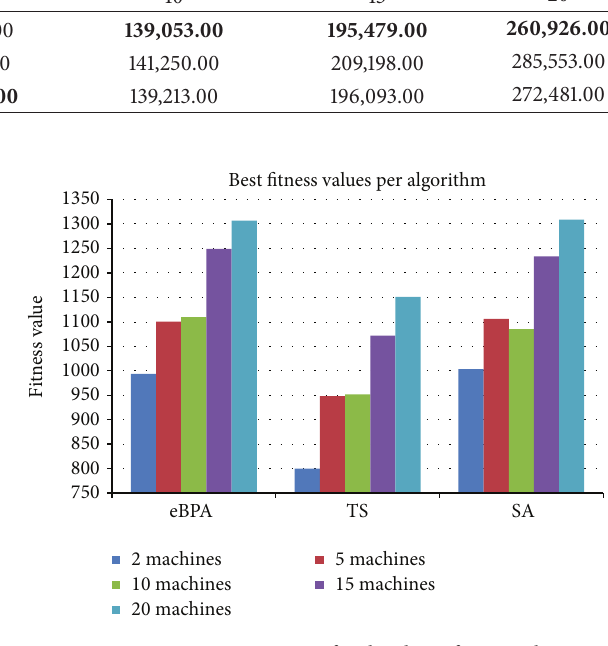
Figure 5: AFV comparisons for the class of 1,500 jobs.